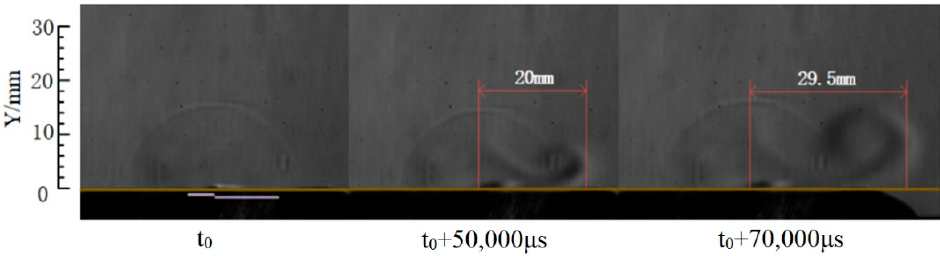
Figure 15. Visualization of the propagating jet flow.